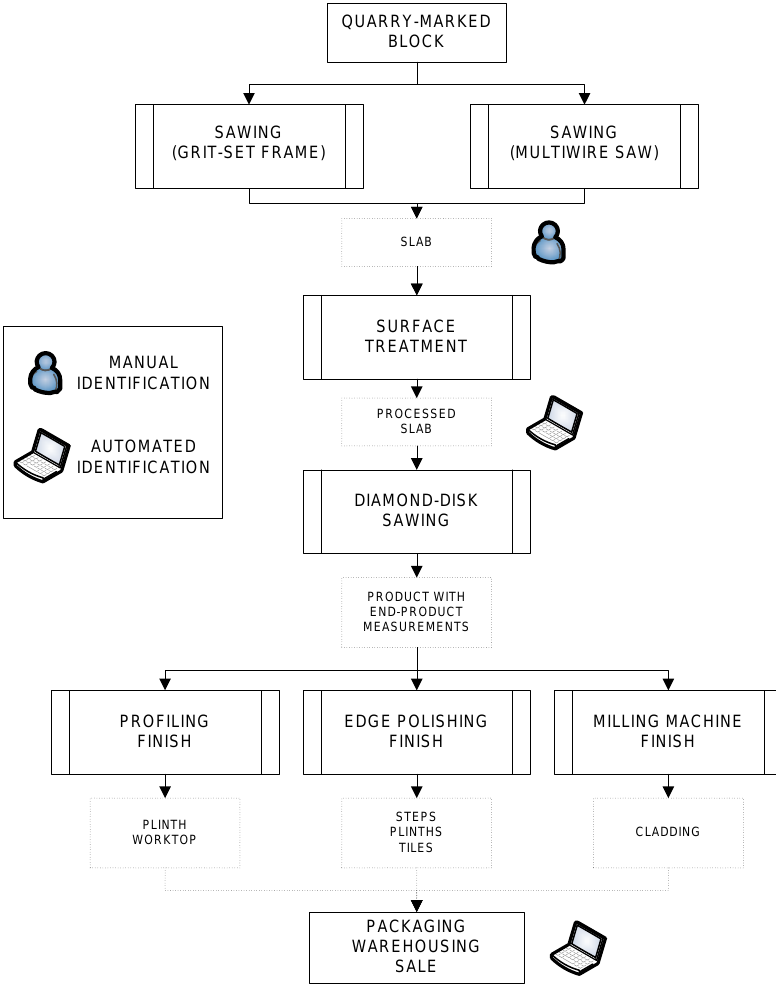
Figure 3. Flowchart depicting the granite production process and indicating phases where manual colour coding can be complemented by automated characterization.